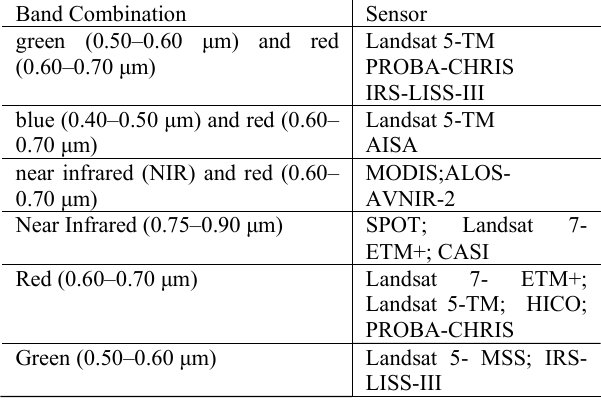
Table 1 – Spectral bands and sensors used in suspended sediments studies with remote sensing, according to Gholizadeh et al